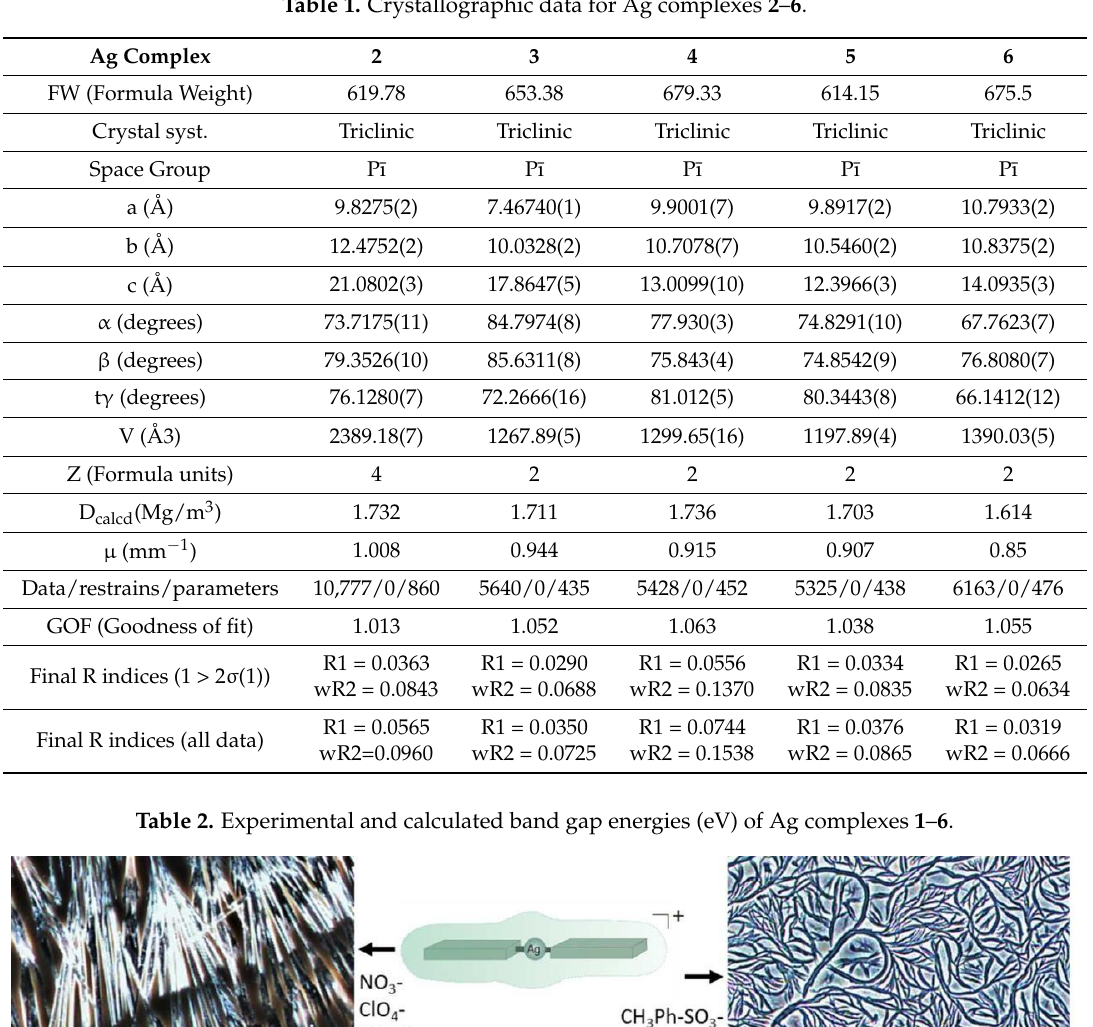
Table 1. Crystallographic data for Ag complexes 2 – 6 .